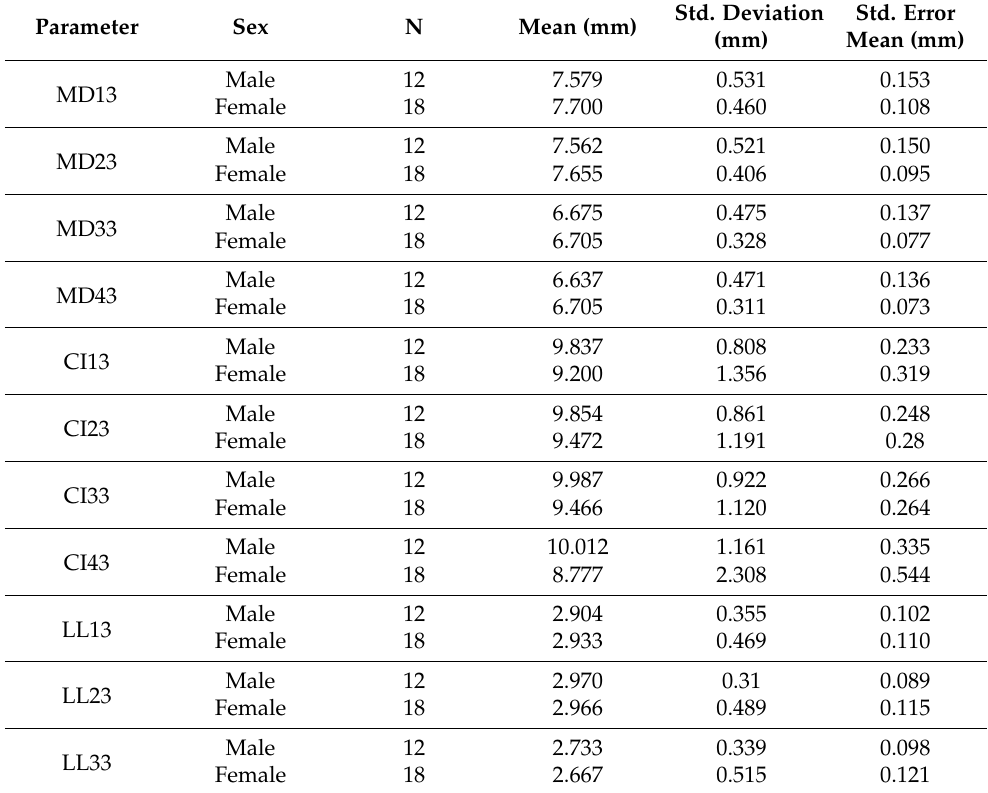
Table 1. The odontometrics of permanent canines based on